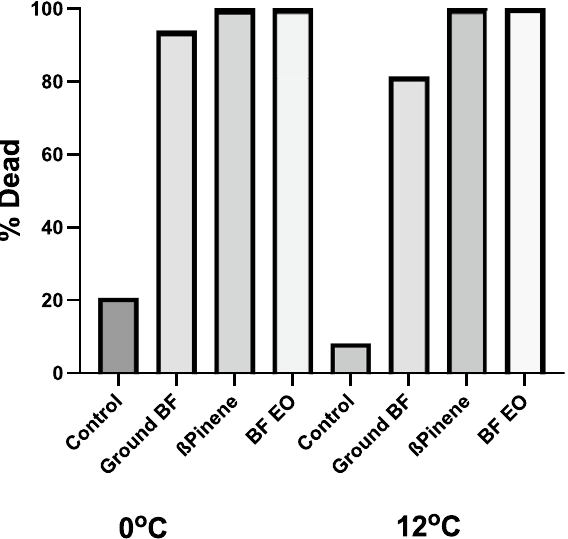
Figure 2. Ground balsam fir needles, ß-pinene and balsam fir essential oil kill ticks at two different temperatures (0 °C and 12 °C). Bars represent the percentage of dead ticks after 4 weeks. BF = Balsam Fir, BF EO = Balsam Fir Essential Oils. Control N = 24/incubator, Ground BF N = 16/incubator, ß-pinene N = 24/ incubator, BF EO N =